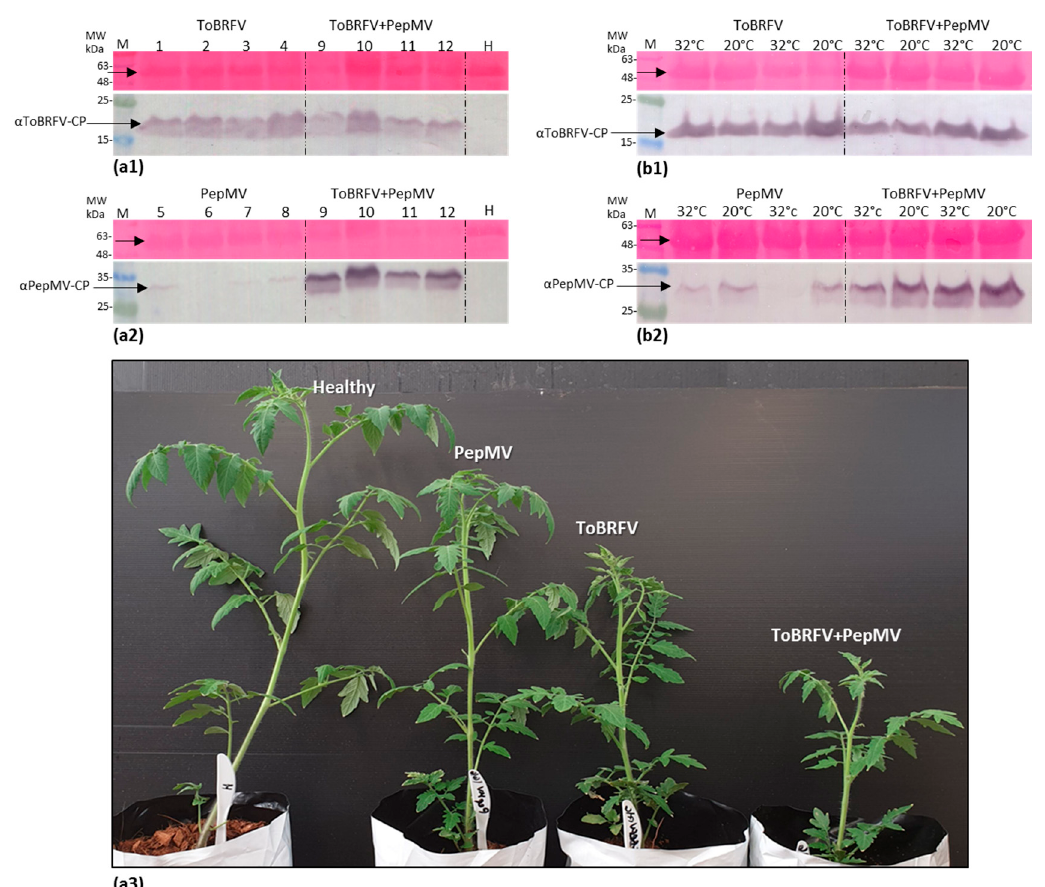
Figure 4. Enhanced pepino mosaic virus (PepMV) titers in tomato brown rugose fruit virus (ToBRFV) and PepMV co-inoculated tomato plants compared to PepMV singly inoculated plants. ( a1 , 2 ) Western blot analyses showing coat protein (CP) levels of ToBRFV and PepMV in singly and mixed-inoculated tomato plants grown under uncontrolled temperatures (at a temperature range of 25–45 °C). ( a3 ) A prominent reduction in plant heights observed in the mixed-inoculated tomato plants grown at a temperature range of 25–45 °C. ( b1 , 2 ) Western blot analyses showing CP levels of ToBRFV and PepMV in singly and mixed-inoculated tomato plants, grown under controlled temperatures of 20 and 32 °C. H, healthy controls; M, molecular size marker; arrows indicate the two viral CPs and a constantly expressed plant protein stained by Ponceau-S dye.